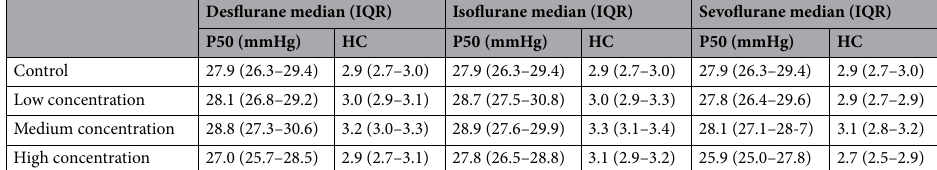
Table 3. P50 and HC (median and interquartile range, IQR) of controls and three inhaled anesthetics at low, medium and high concentration. P50 oxygen partial pressure at 50% saturation, HC the Hill